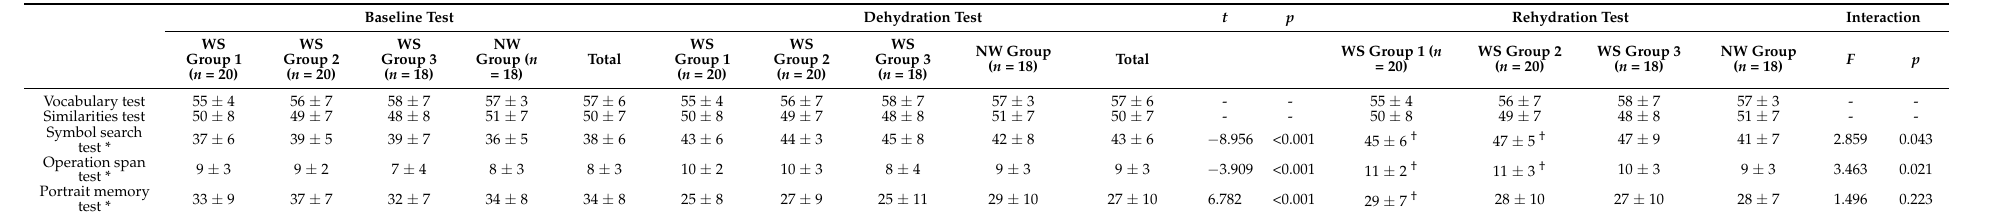
Table 7. The CP of